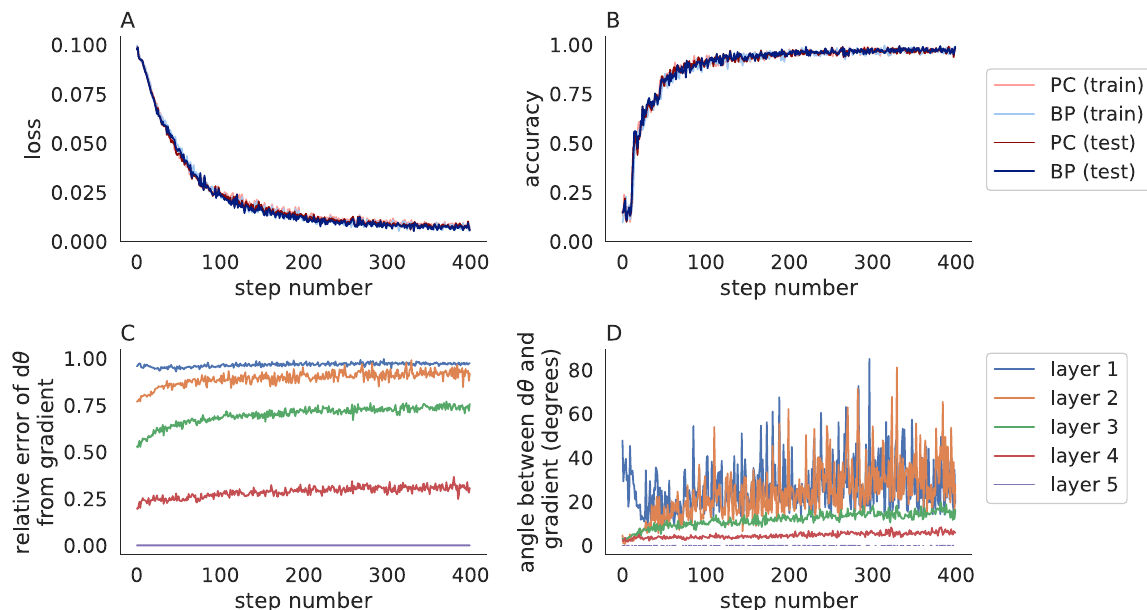
Fig 1. Comparing backpropagation and predictive coding in a convolutional neural network trained on MNIST. A,B) The loss (A) and accuracy (B) on the training set (pastel) and test set (dark) when a 5-layer network was trained using a strict implementation of predictive coding (Algorithm 2 with η = 0.1 and n = 20; red) and backpropagation (blue). C,D) The relative error (C) and angle (B) between the parameter update, dθ , computed by Algorithm 2 and the negative gradient of the loss at each layer. Predictive coding and backpropagation give similar accuracies, but the parameter updates are less